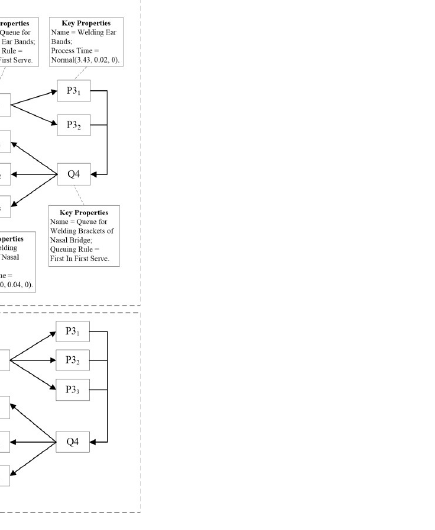
Fig 5. Production line scenario simulation